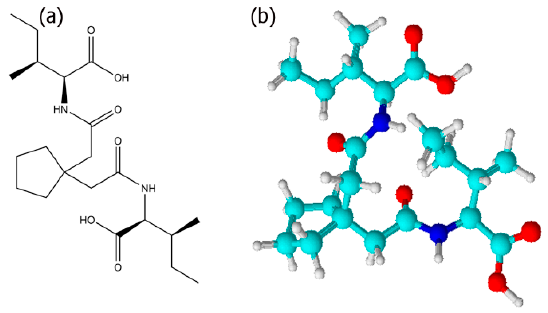
Figure 1. ( a ) Chemical structure of Ile-TMG-Ile; ( b ) ball and stick model.